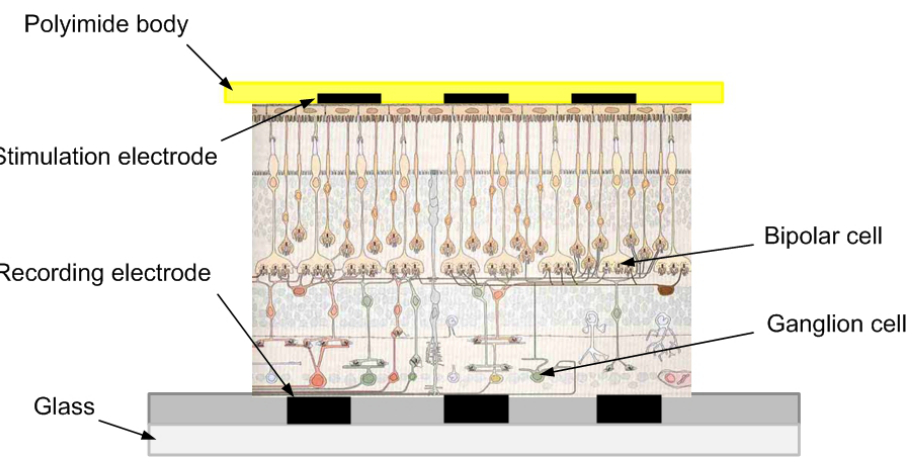
Figure 2. Fixture for stimulation MEA. ( a ) Upper thick part with MEA on